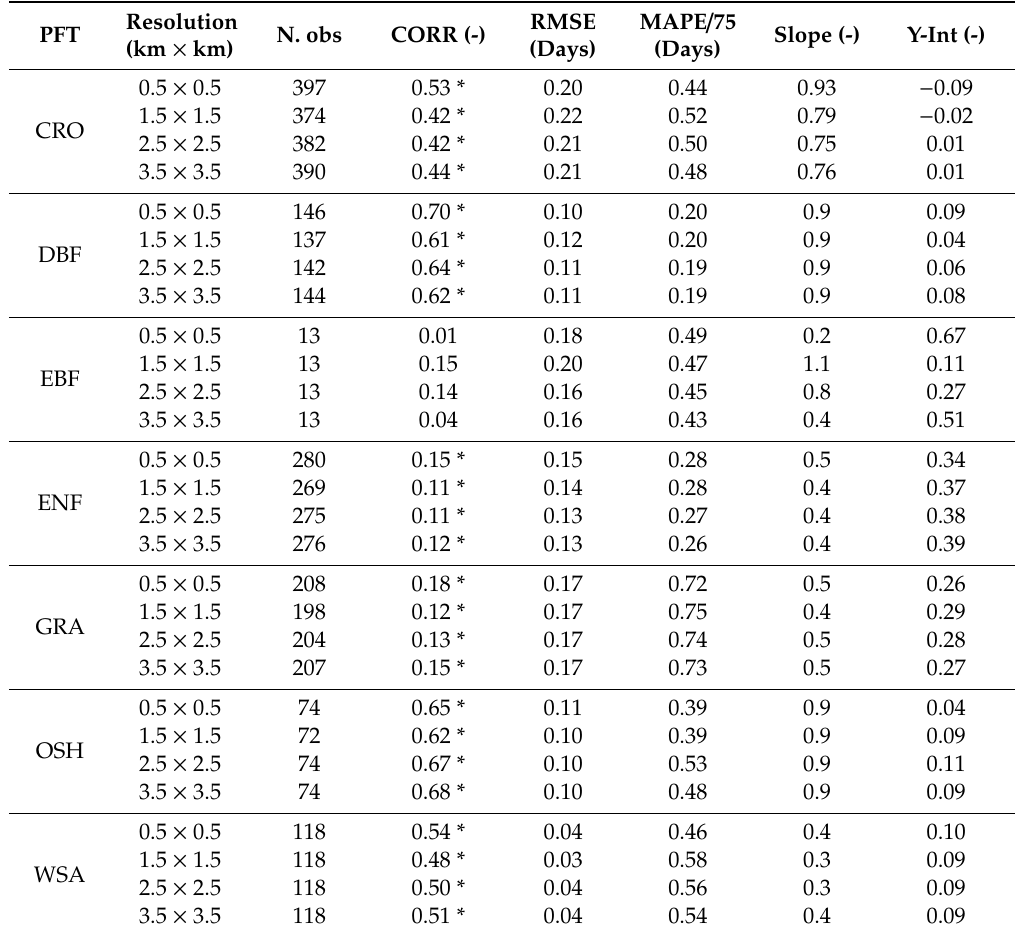
Table 3. Results of the regression analysis of the relationship between NDVI is and NDVI MD at di ff